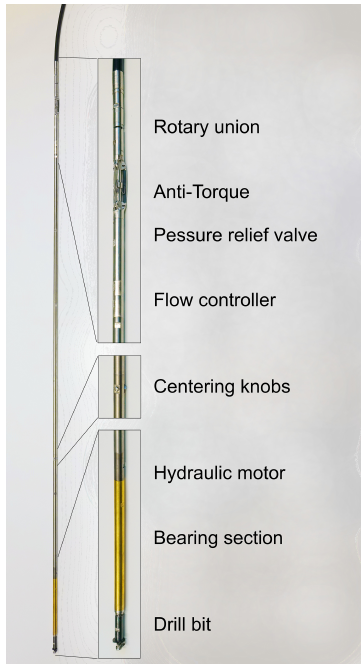
Figure 5. RADIX fluid drill with tungsten extension tubes con- nected to the hydraulic hose (top).